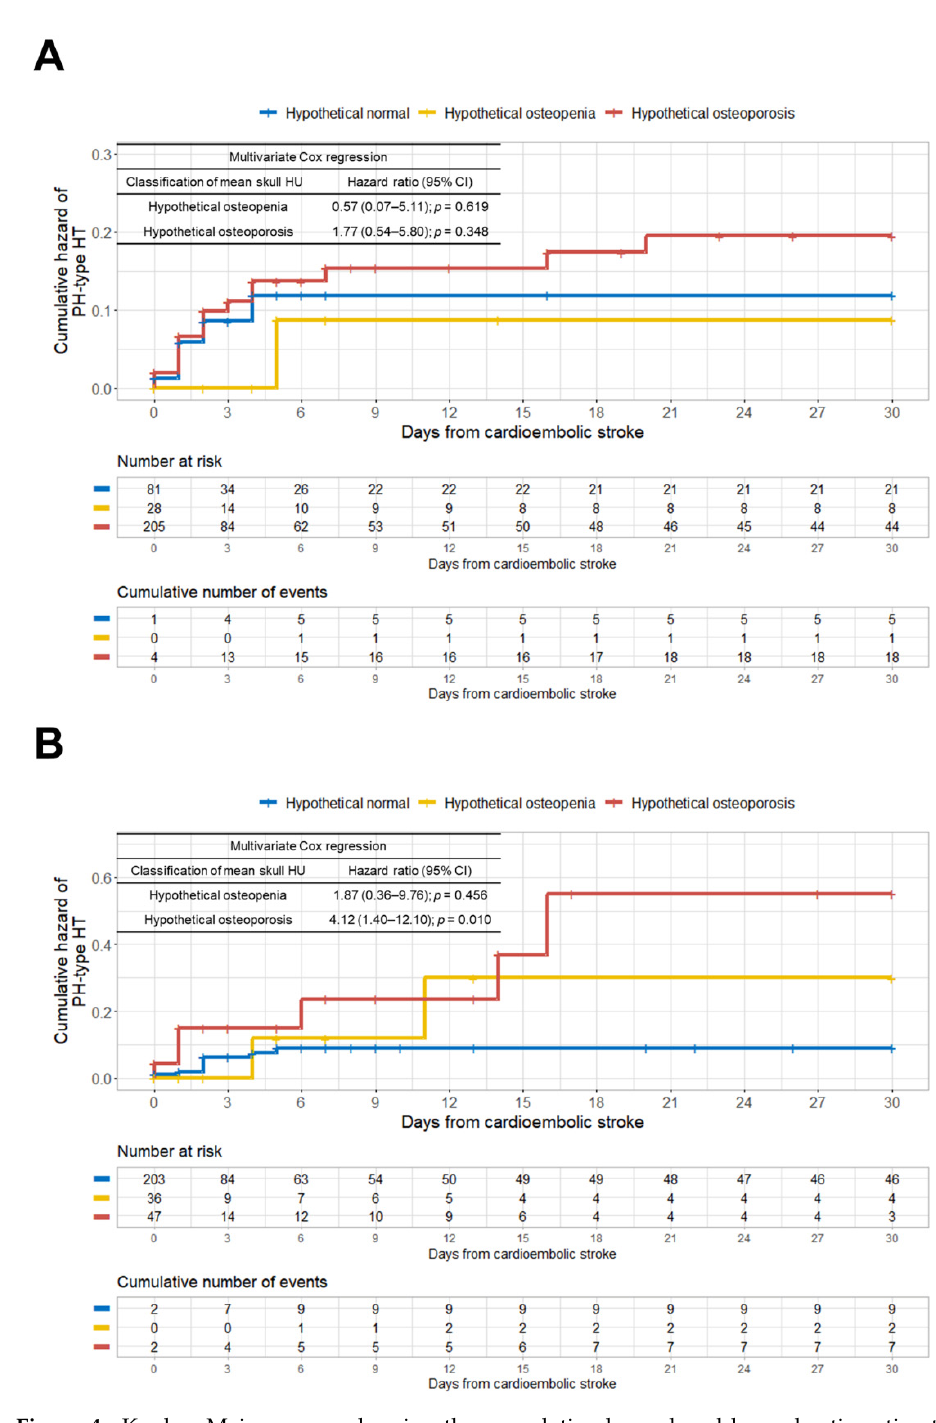
Figure 4. Kaplan–Meier curves showing the cumulative hazard and hazard ratio estimated by the multivariate Cox regression analysis for the development of PH-type HT in the study patients according to the hypothetical BMD groups classified by sex. ( A ) Female; ( B ) male. PH = parenchymal hematoma; HT = hemorrhagic transformation; BMD = bone mineral density.